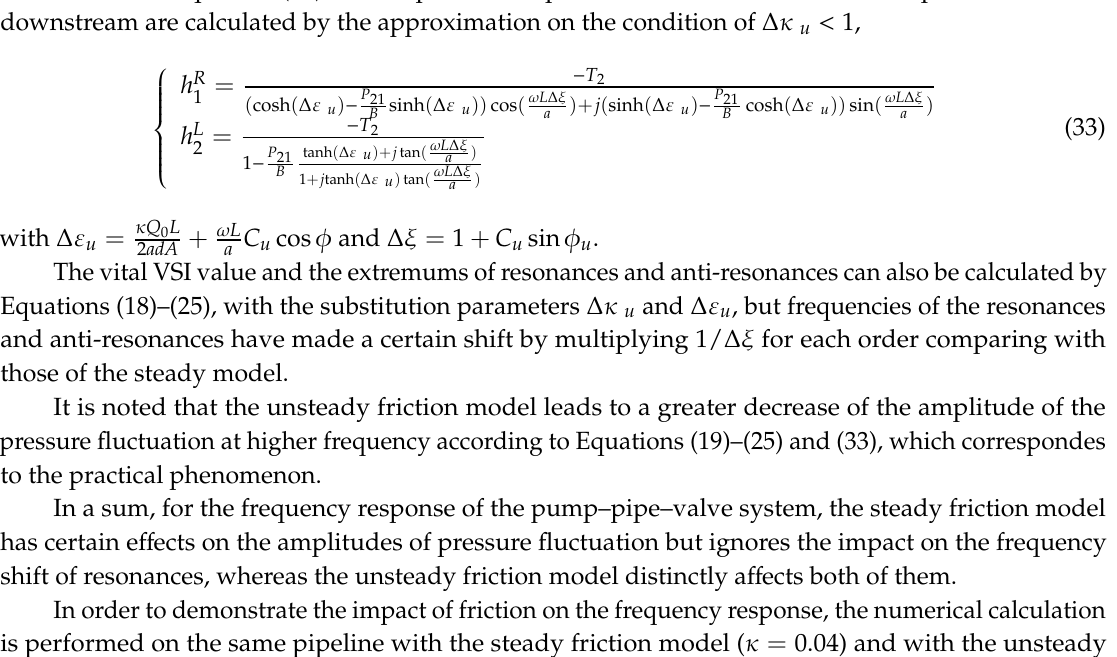
Figure 4. Impacts of the Darcy–Weisbach steady friction model ( κ = 0.04) on the frequency response with three VSI conditions.